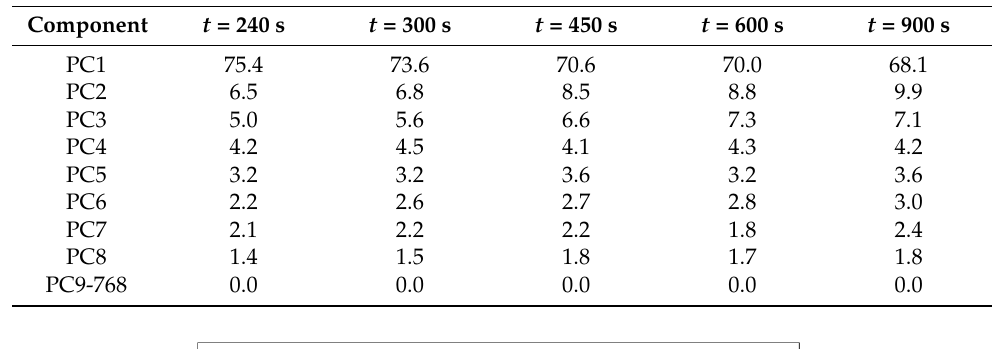
Table 1. Percentage of total variance of data covered by principal components calculated for different measurement times.